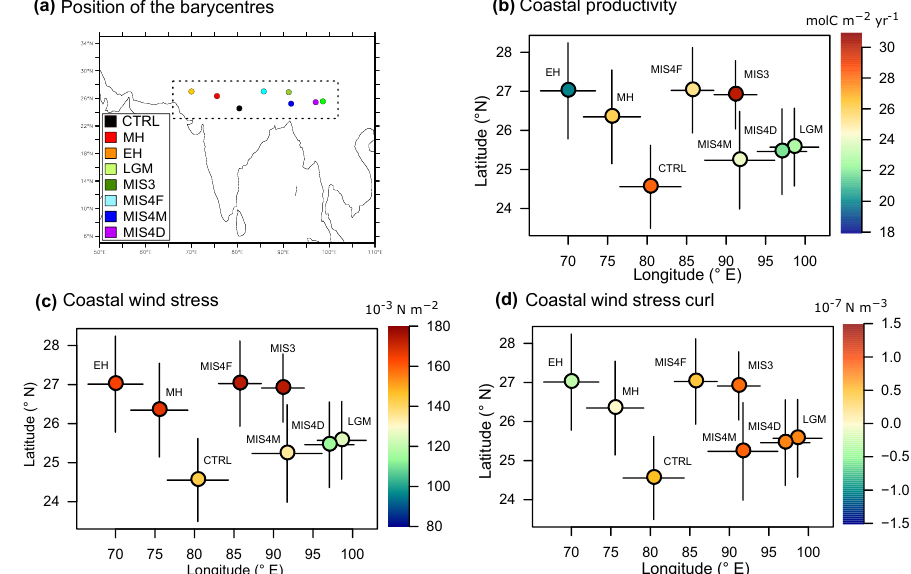
Figure 11. (a) Position of the SLPa-5 barycentre for the eight simulations. Seasonal (JJAS) coastal (b) productivity (molCm − 2 yr − 1 ), (c) wind stress intensity (10 − 3 Nm − 2 , y axis) and (d) wind stress curl intensity (10 − 7 Nm − 3 , x axis) as a function of the SLP barycentre longitude and latitude. Errors bars give standard deviation of the 100 summers. The dotted black box in panel (a) represents the region on which we zoomed for panels (b–d) .